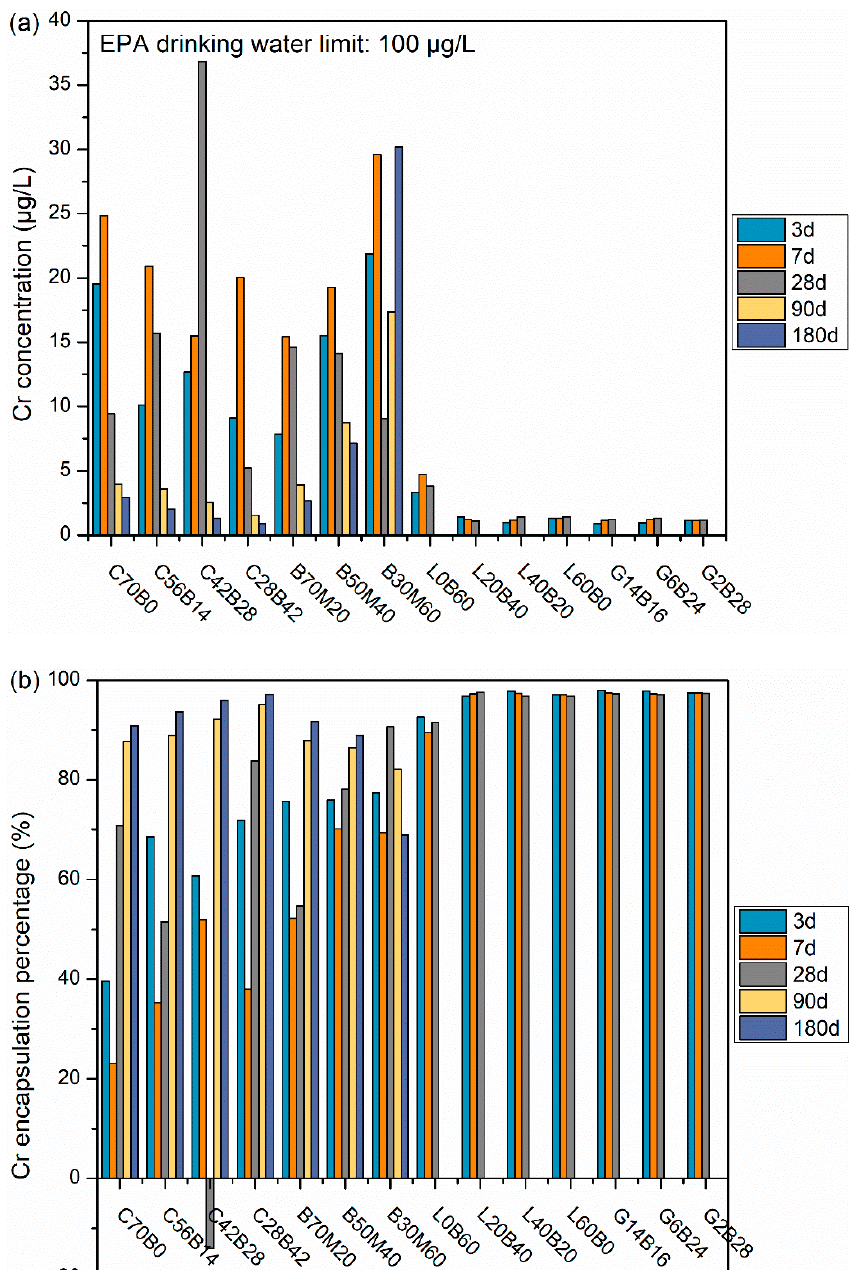
Figure 5. The ( a ) Cr concentration and ( b ) encapsulation percentage for the leachate in all groups at all ages.